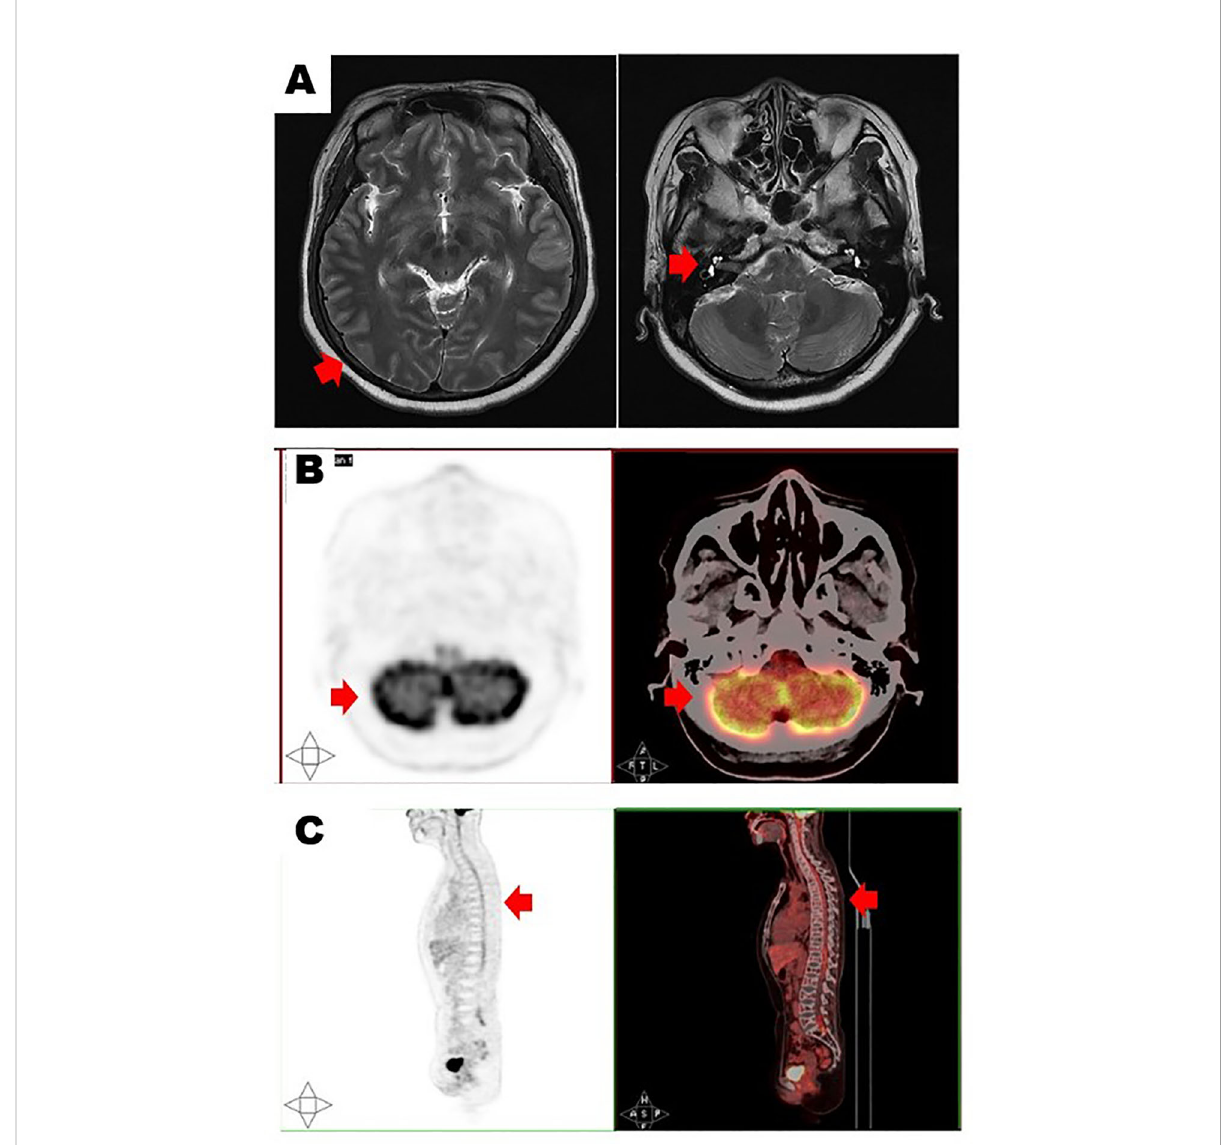
FIGURE 1 Brain magnetic resonance imaging (A) showed cerebrospinal meninges (left, red arrow) and auditory nerve thickening (right, red arrow). Positron emission tomography/computerized tomography in transverse section (B) and longitudinal section (C) showed multiple cerebrospinal meninges with increased 18F- fl urodeoxyglucose metabolism (red